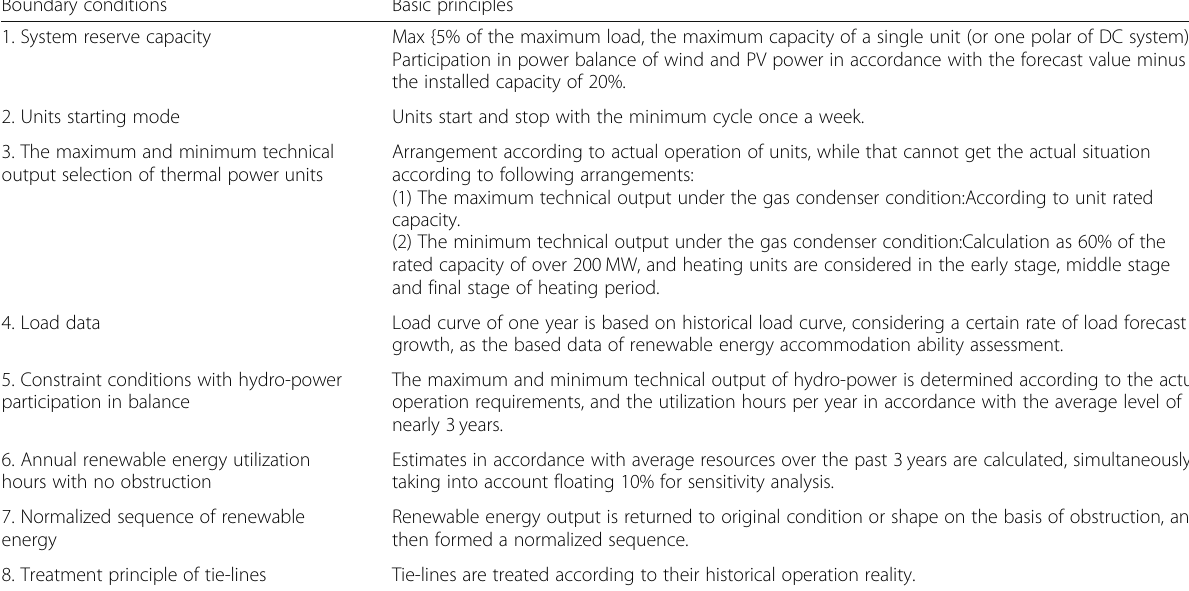
Table 1 Boundary condition of renewable energy accommodation capacity in “ Three North ” region of China in 2020 Boundary